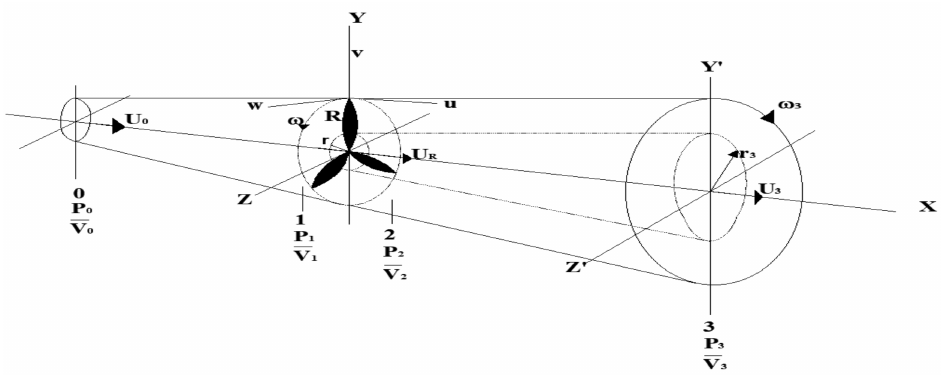
Figure 2. CV illustrating the